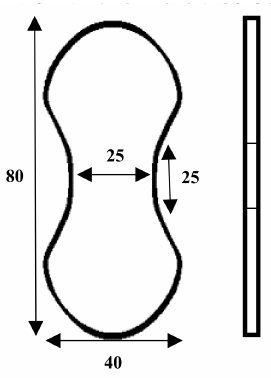
Figure 4. Schematic of dog-bone specimen for the CC tensile test.